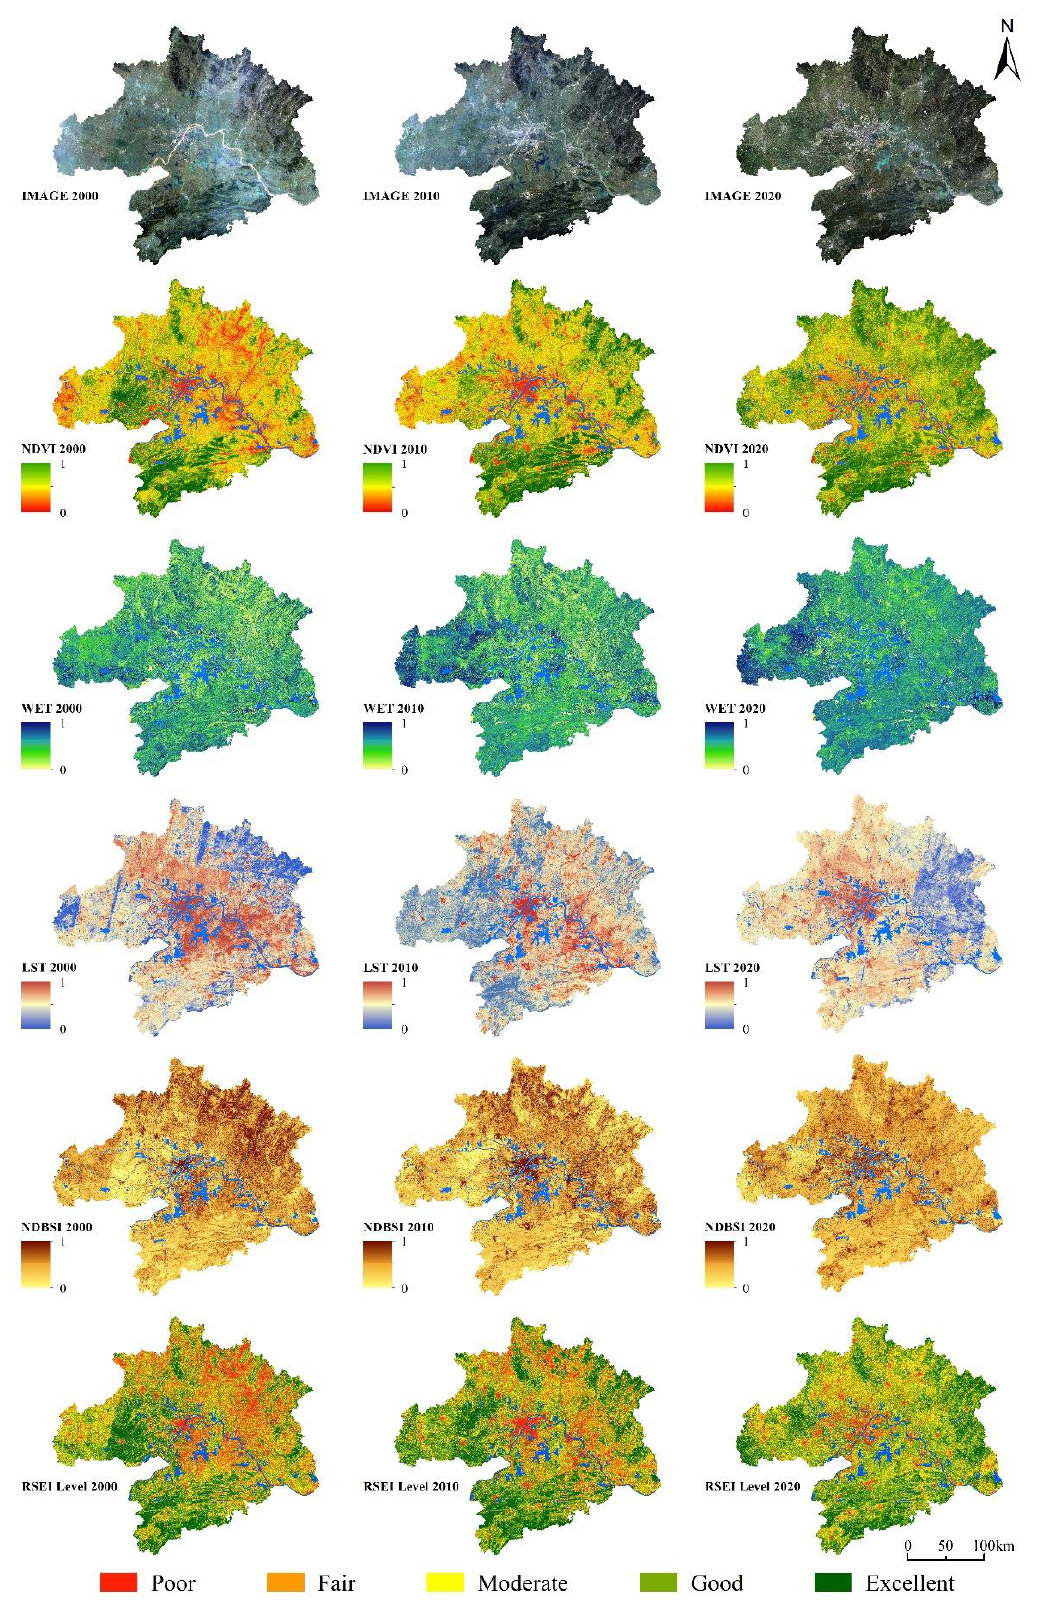
Figure 5. Spatial distribution of ecological quality (calculated with Equations (1) – (13)).